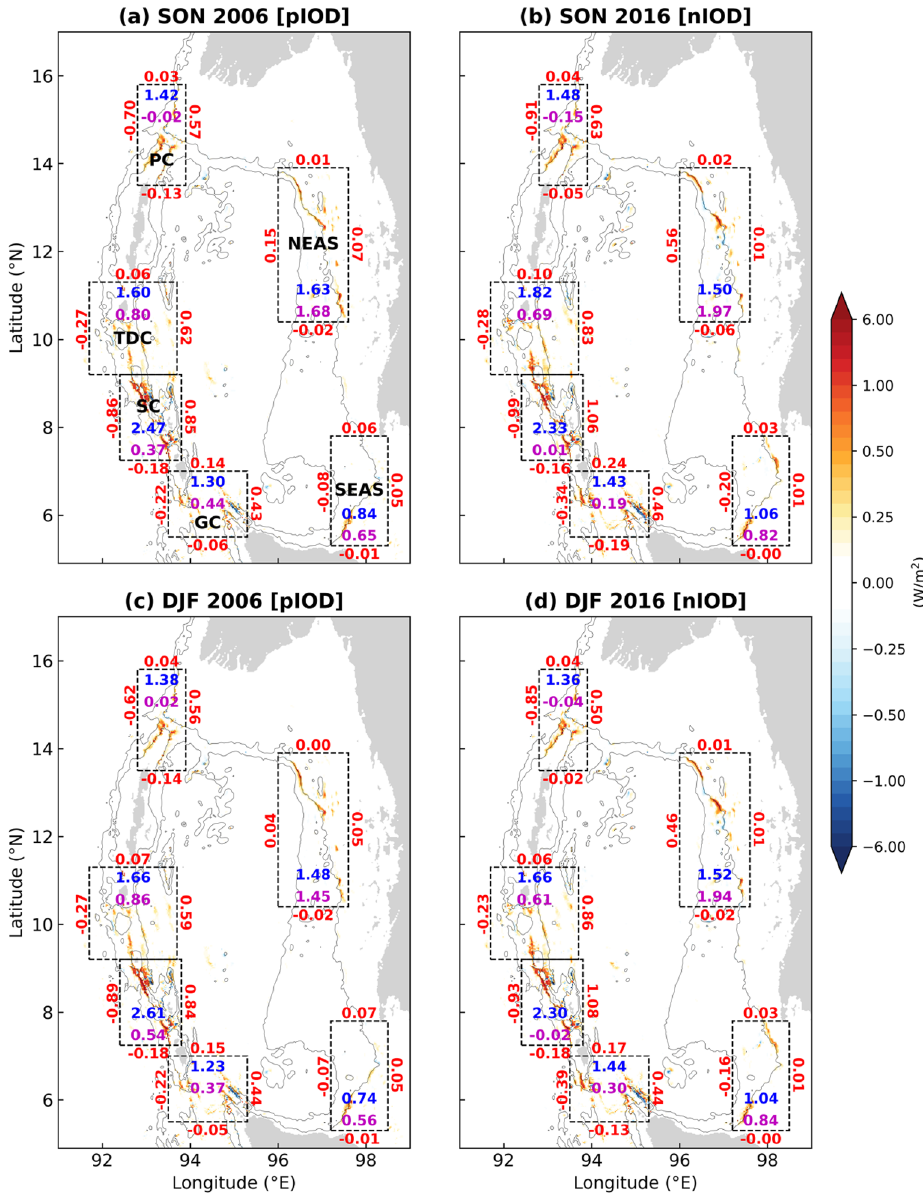
Figure 8. Comparison of baroclinic tidal energy budget between ( a , c ) pIOD and ( b , d ) nIOD during ( a , b ) Autumn and ( c , d ) Winter. The nonuniform color bar indicates the depth-integrated conversion rates from barotropic to baroclinic tide. The region-integrated and depth-integrated energy conversion (GW) and baroclinic dissipation (GW) are represented by blue and magenta numbers inside the box, respectively. Red numbers show the depth-integrated baroclinic energy fluxes (GW) along the